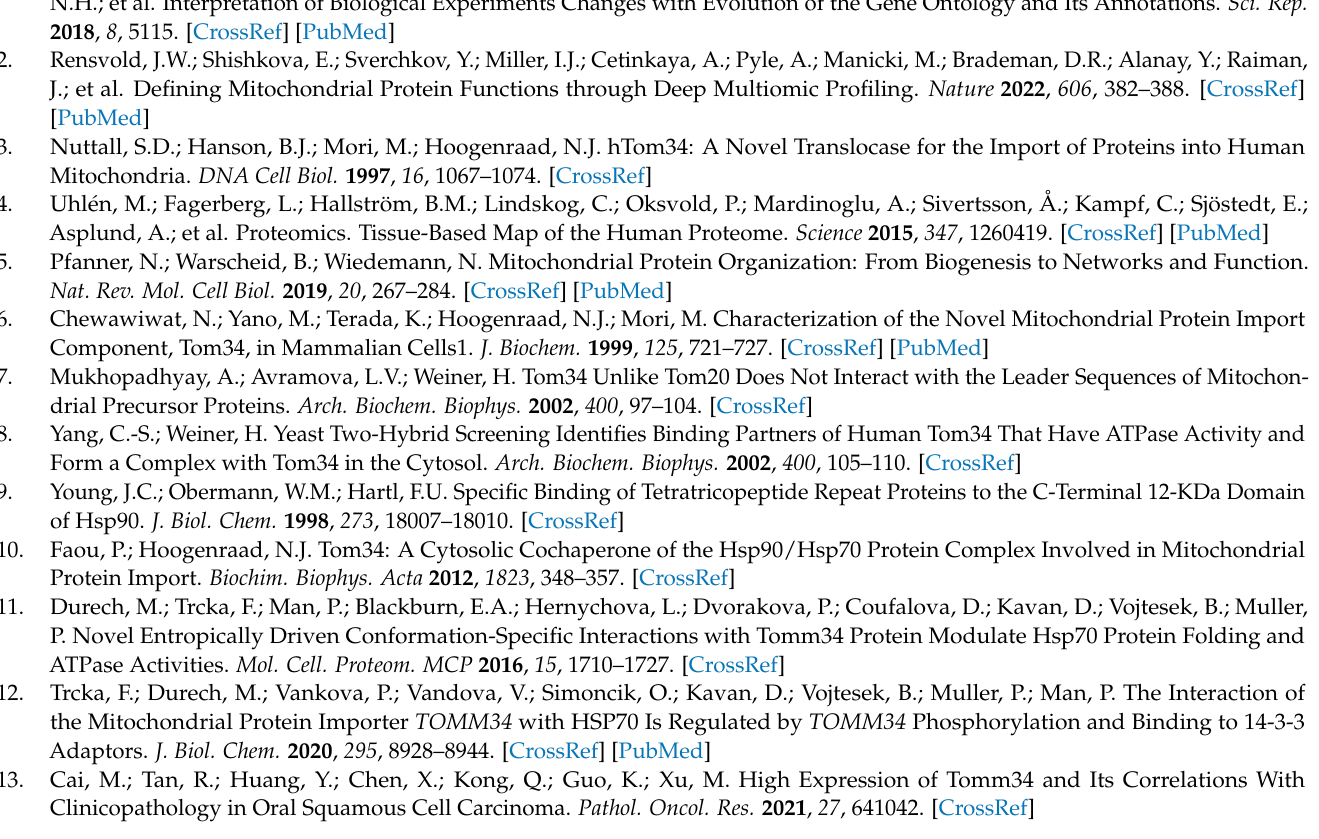
Figure S1: Western blot result: TOMM34 protein level in WT and KO HepG2